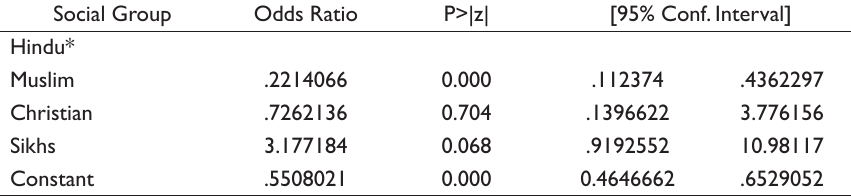
Table 7. Logistic Regression Model for Religious Groups in